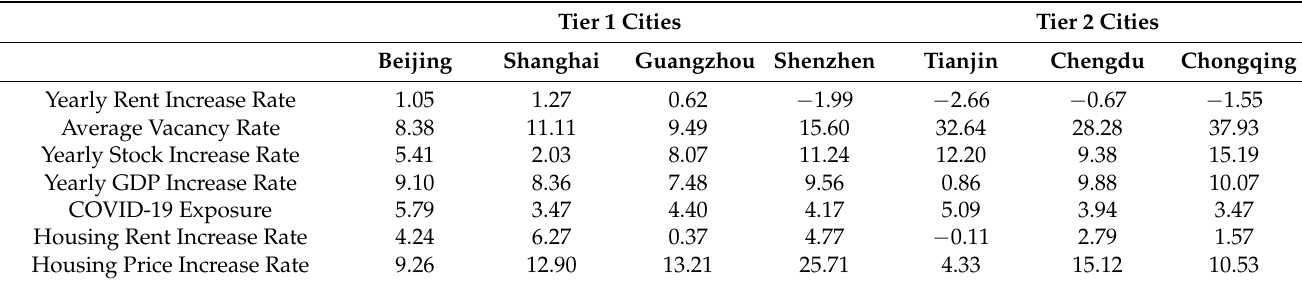
Table 3. Key variable of 7 Chinese cities from 2013 Q3 to 2022 Q2